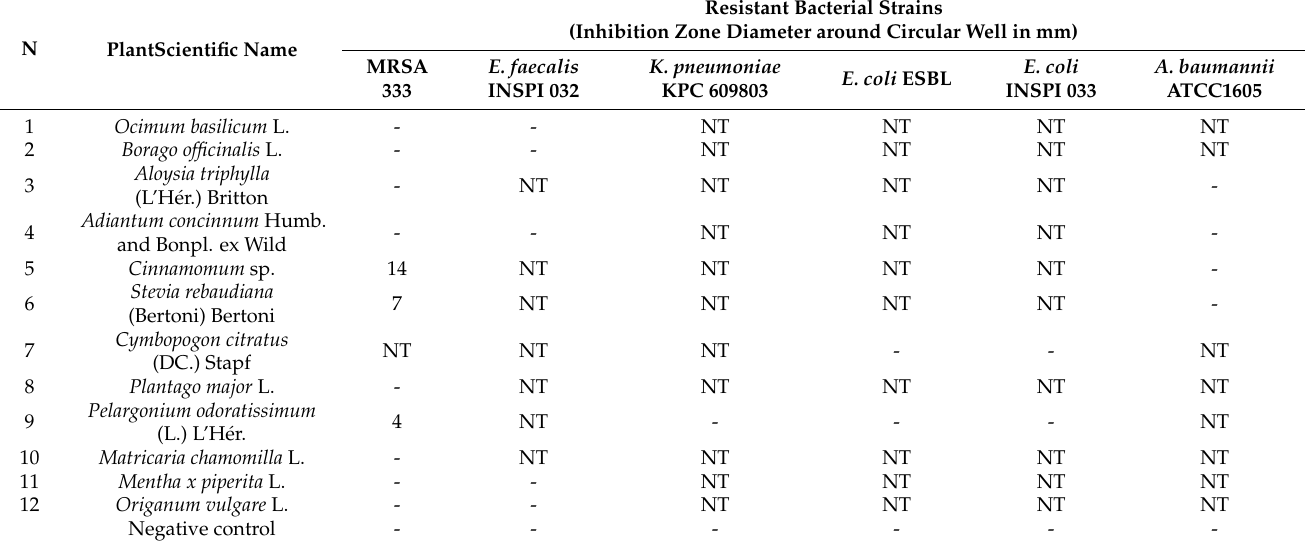
Table 3. Antibacterial activity of crude plant extracts used in the herbal infusion horchata against resistant bacterial strains of clinical importance determined by the well diffusion